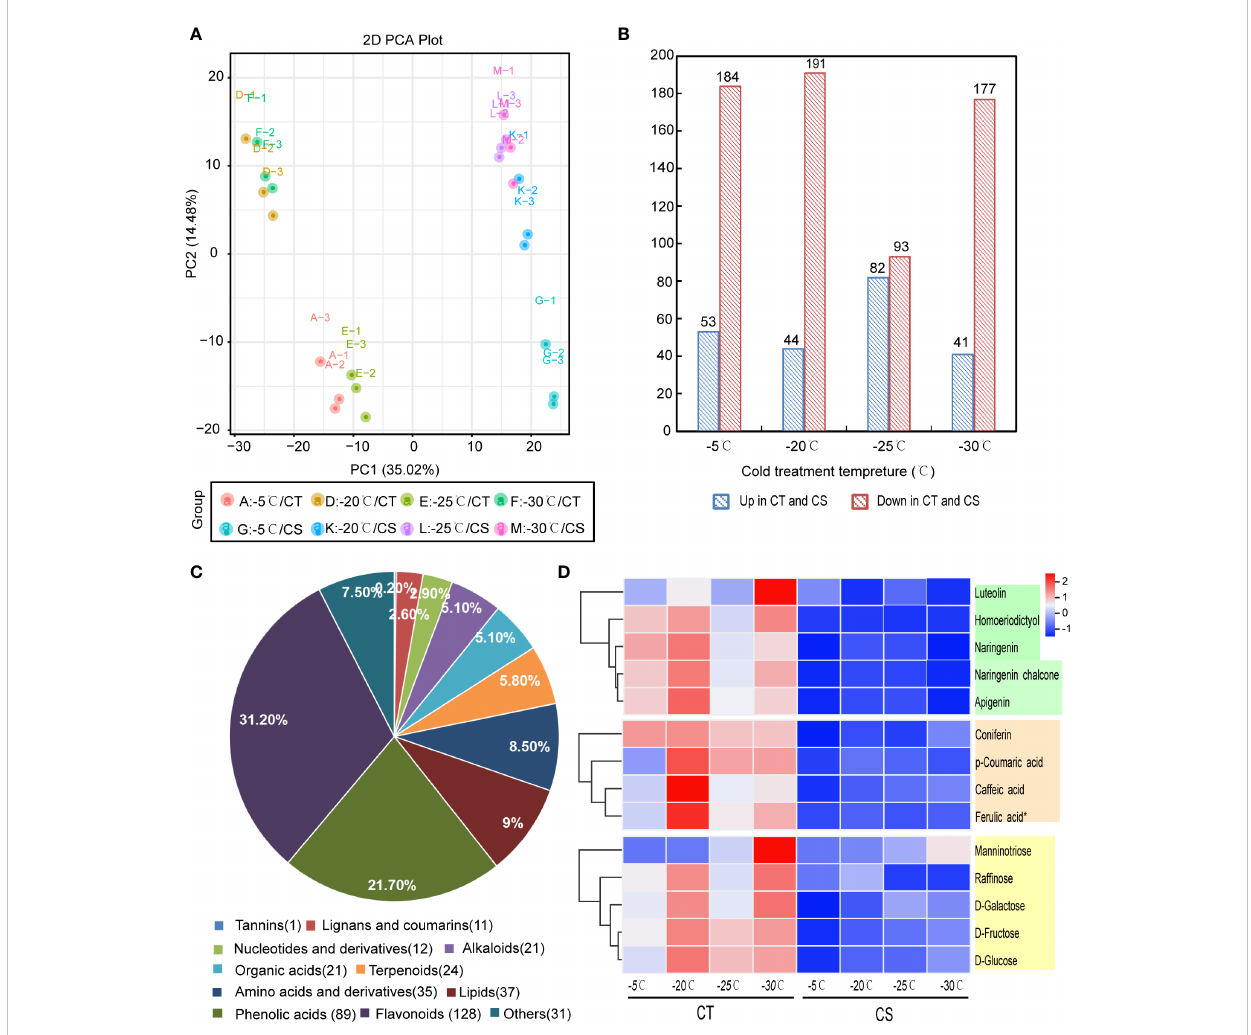
FIGURE 2 Metabolomics analysis of CT and CS under cold stress. (A) PCA of metabolites derived from CT and CS under cold. (B) Signi fi cantly differentially expressed metabolites (DEMs) between the CT and CS under cold stress. (C) Classi fi cation of DEMs in peach under cold stress. (D) The accumulation pattern of fl avonoids (green), saccharides (orange), and phenolic acids (yellow) in CT and CS under cold stress. Scaled values of the relative contents of metabolites were used for z-scale